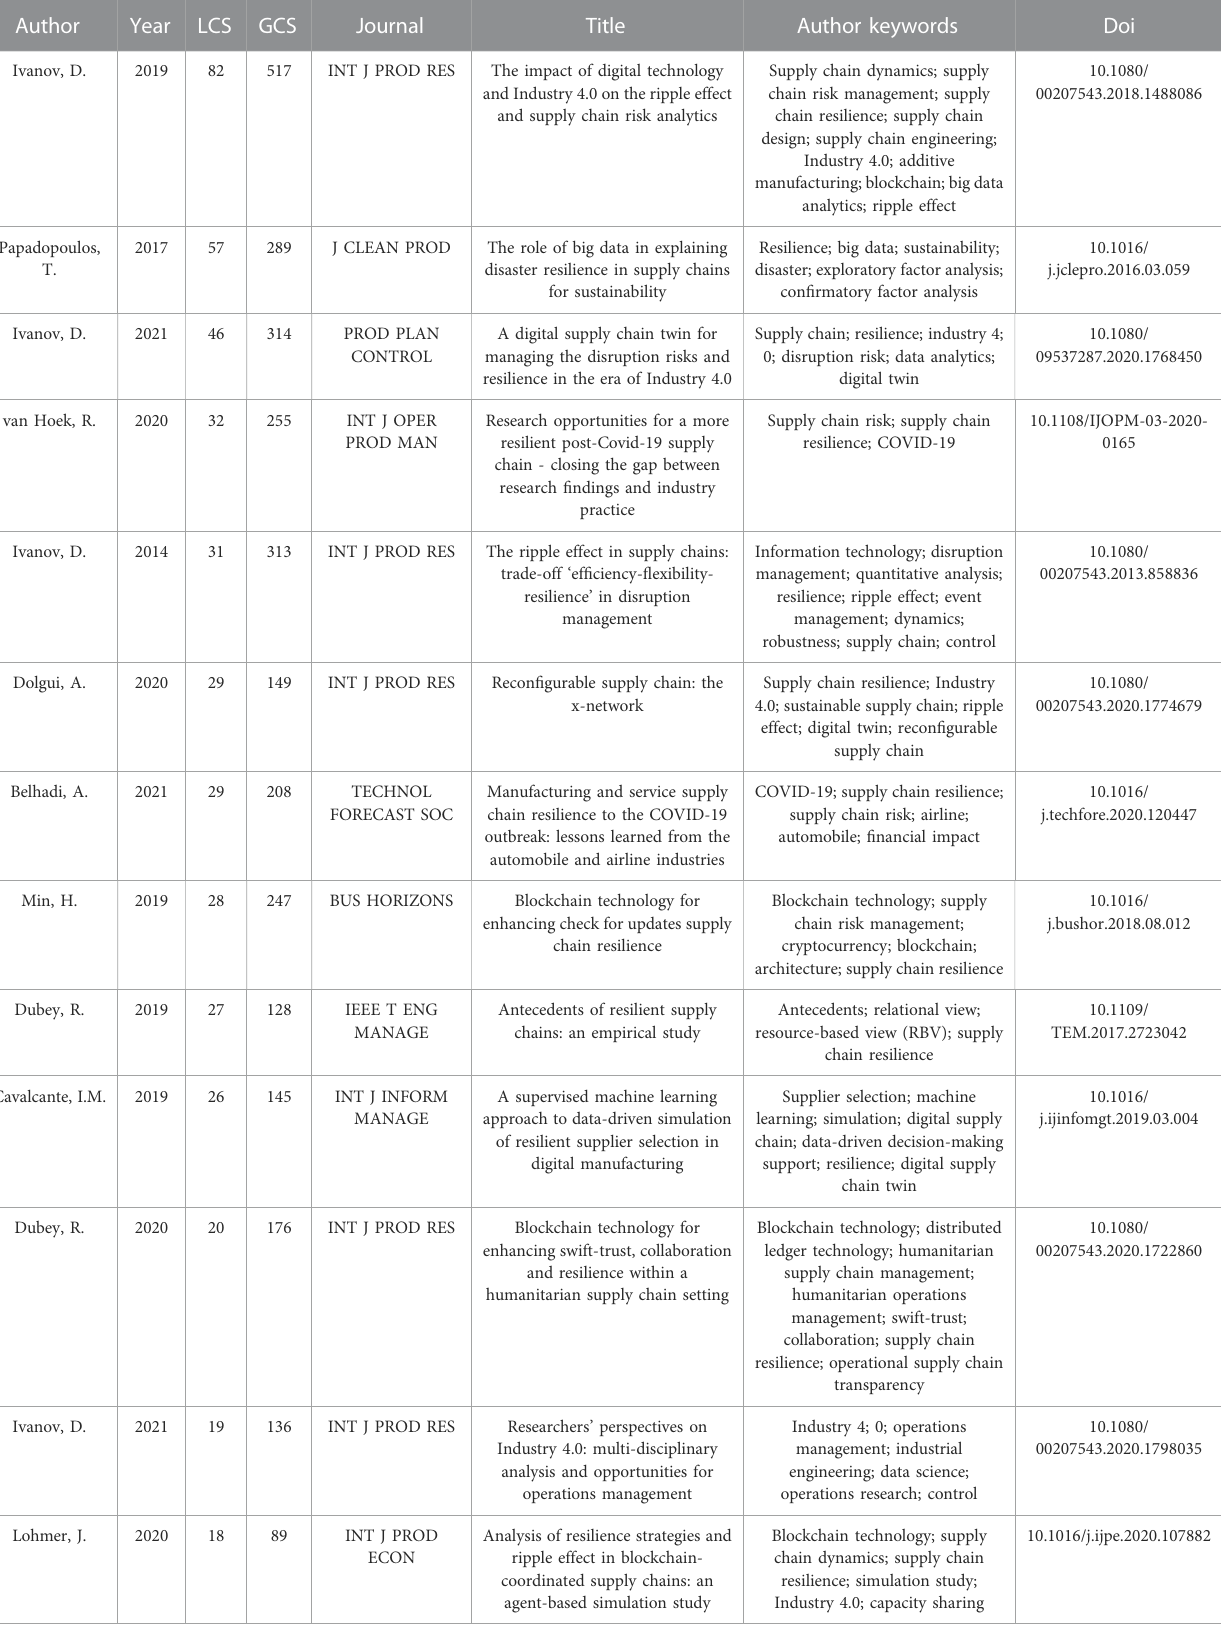
TABLE 2 Detailed information of historiograph articles, ordered fi rst by cluster and then by